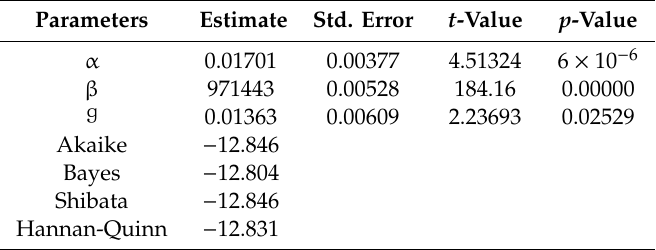
Table A1. Parameter Estimates of Hong Kong’s Islamic-conventional ADCC-GARCH model. Figure A4. Islamic-conventional stock returns Wavelet correlations for Americas’ region markets. Table A2. Parameter Estimates of New Zealand’s Islamic-conventional ADCC-GARCH model.